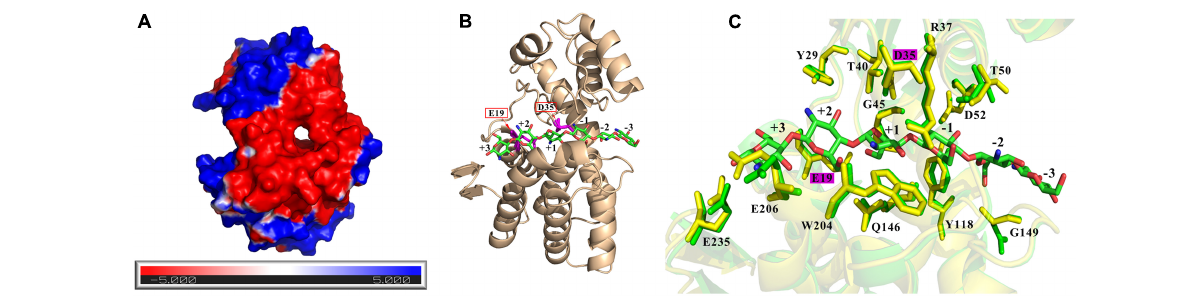
Frontiers in Microbiology |